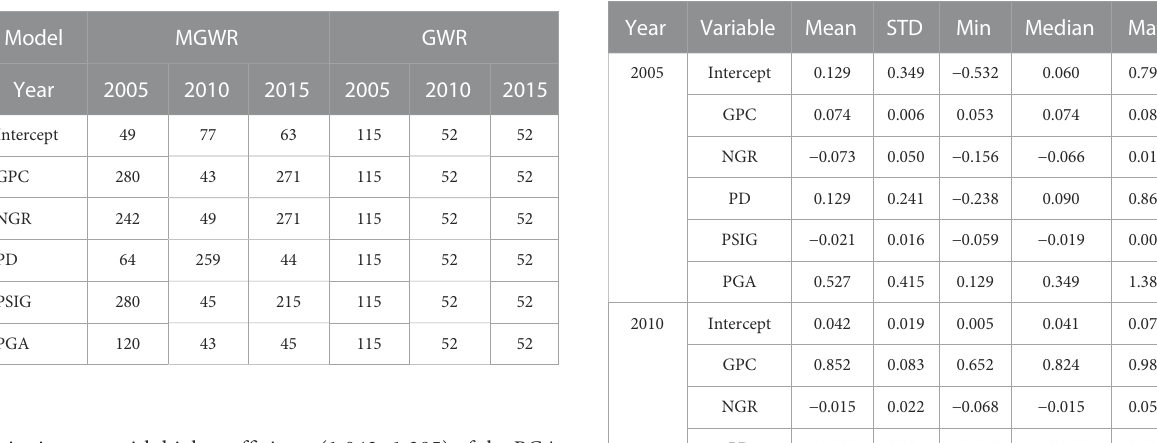
TABLE 5 Coef fi cient statistics of the MGWR